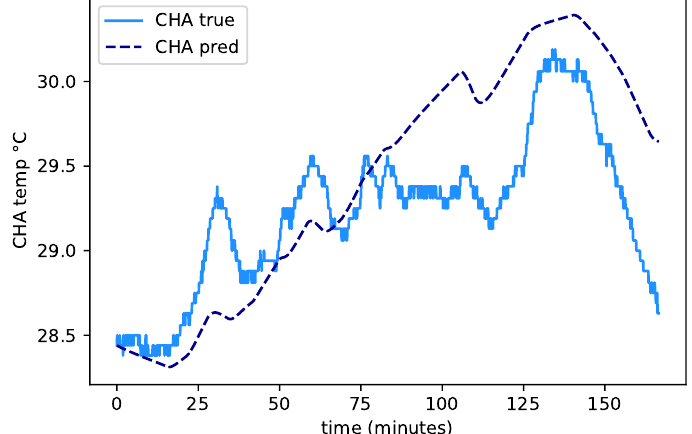
Figure 10. Corresponding test set long-term predictions for chamber